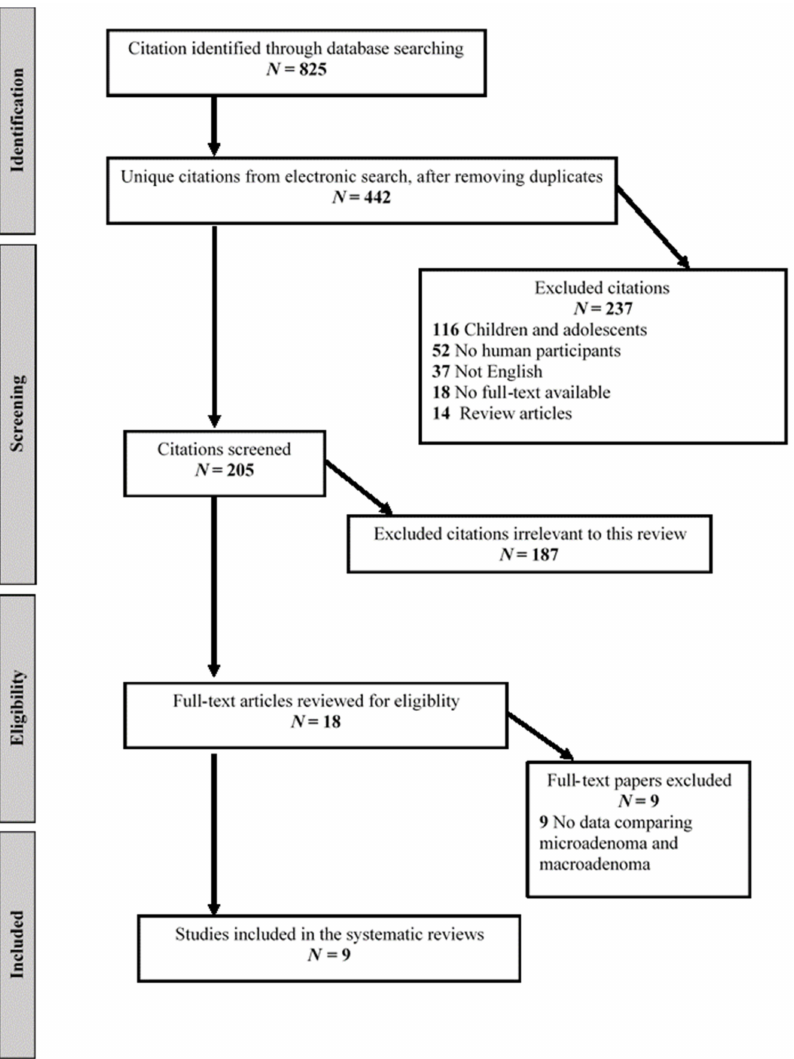
Figure 1. Systematic review flow